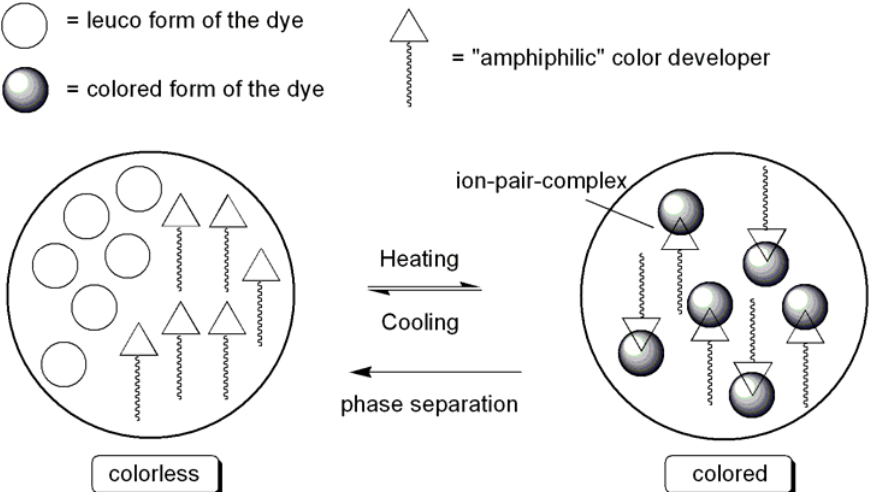
Figure 7. Thermochromic behavior of dye/developer